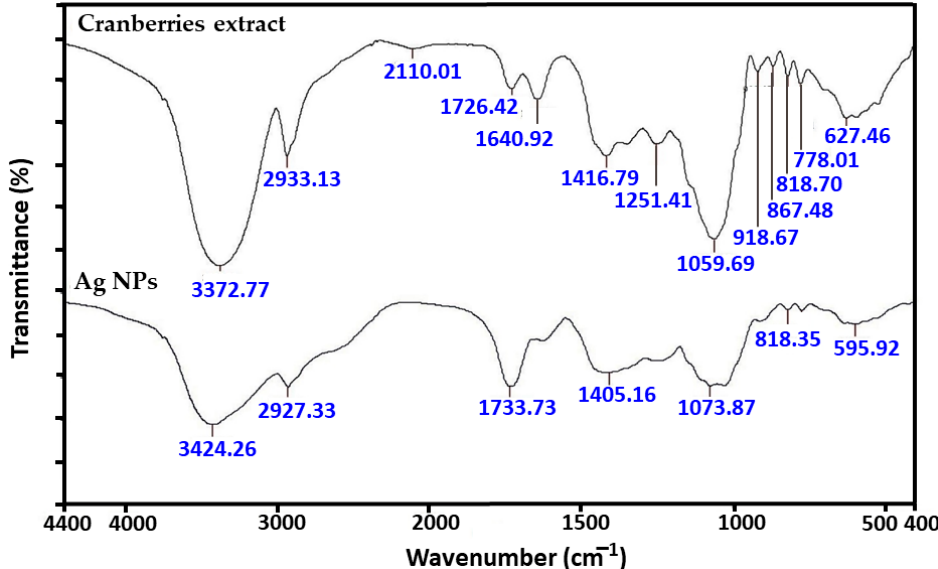
Figure 4. FT-IR pattern of pure cranberry extract powder and Ag NPs prepared using cranberry extract as reducing agent.